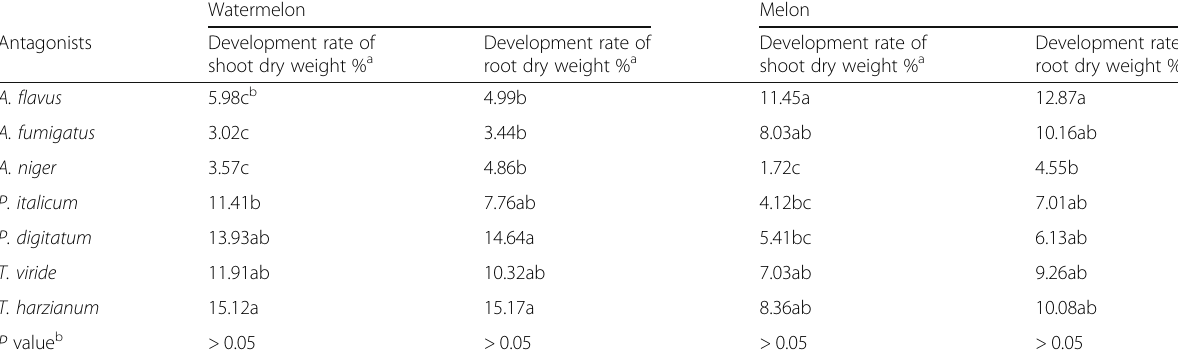
Table 8 Beneficial effect of four Aspergillus spp. isolates, two Penicillium spp. isolates, and two Trichoderma spp. isolates, on watermelon and melon plants in vivo assay, revealed by development rate of shoot and root dry weights